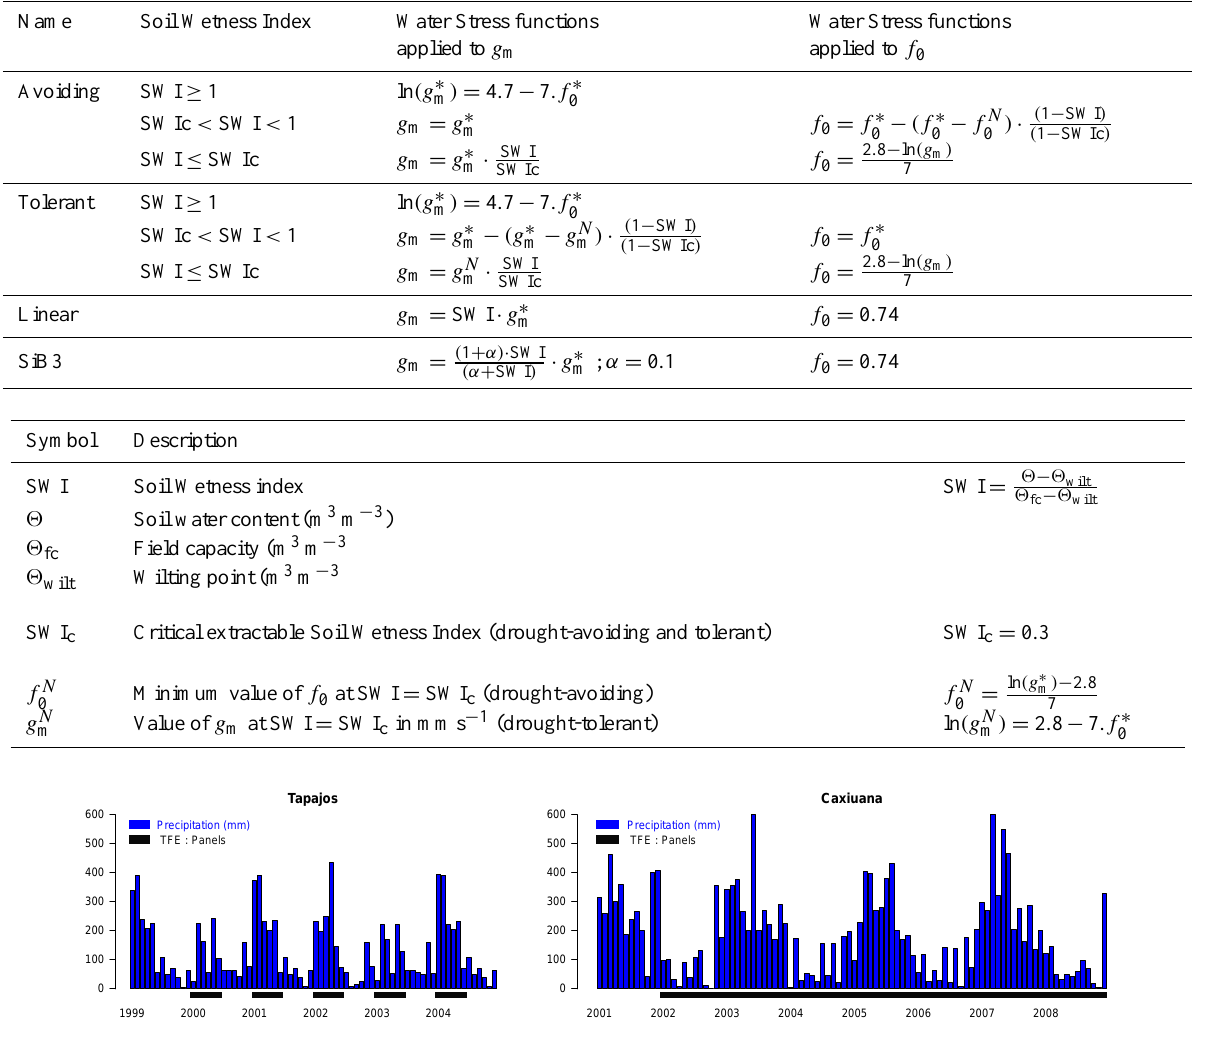
Figure 2. Monthly observed precipitation at Tapajós and Caxiuanã. Horizontal black bars indicate when panels were applied for the through- Figure 2 – Monthly observed precipitation at Tapaj´os and Caxiuan˜a. Horizontal black bars indicate when panels were applied fall exclusion (TFE) for the TFE experiments.